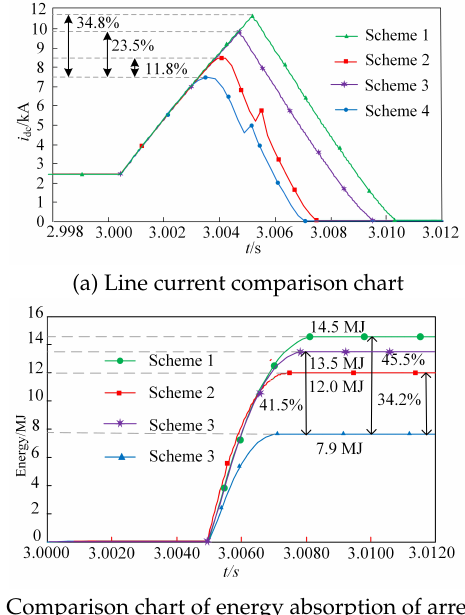
Fig. 9. Schemes comparison: Line current comparison